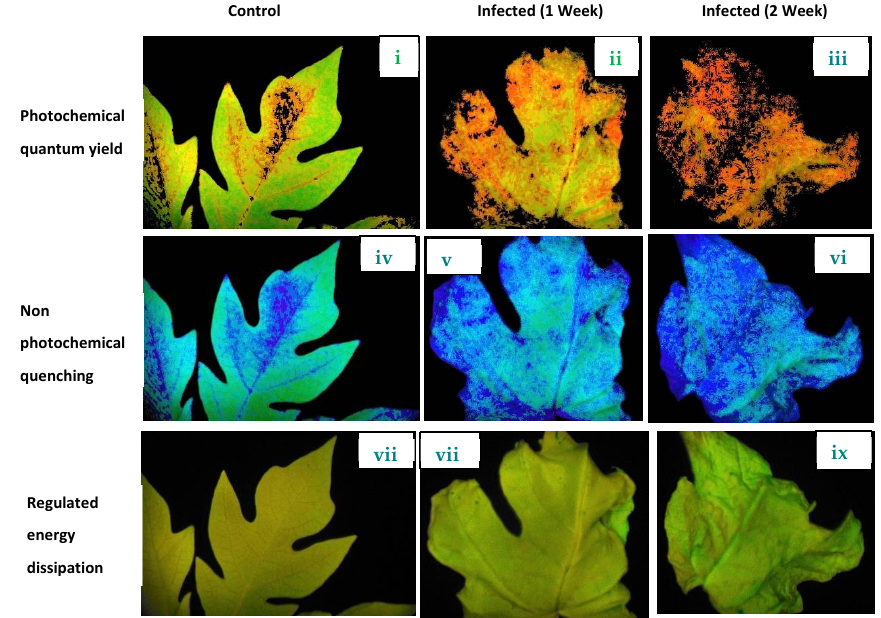
Figure 8. Imaging PAM chlorophyll fluorometer measurements of healthy plant leaf and diseased leaf. The false color scale depicted to the right of images shows the amplitude of the particular parameter. ( i – iii ) Comparison of quantum yield (YII). ( iv – vi ) Non-photochemical quenching (NPQ). ( vii – ix ) Regulated energy dissipation of healthy, mild-stage, and advanced-stage PaLCuV-infected leaves of papaya.